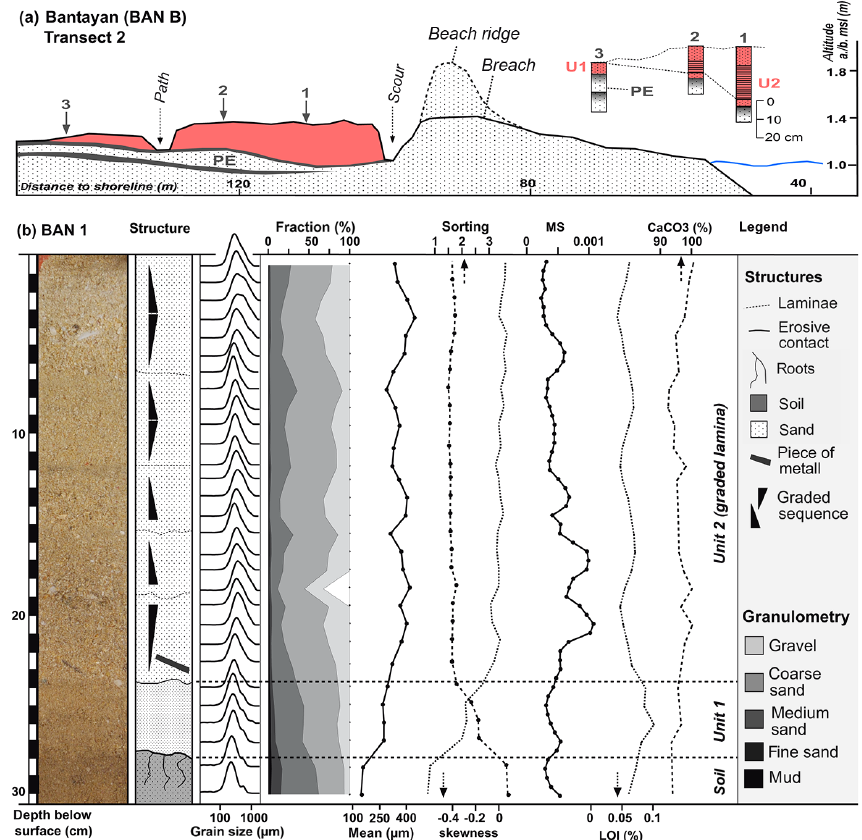
Figure 13. Sedimentary characteristics of Typhoon Haiyan deposits at site BAN B. (a) Transect 2 (see Fig. 11 for location) reveals a landward thinning structure directly behind a storm-induced breach in the coastal barrier. A massive sand sheet at the base (U1) is overlain by a laminated section (U2) in the proximal part of the washover fan. (b) BAN 1 is composed of two distinct units: a massive unit at the base (unit 1) and a laminated unit on top (unit